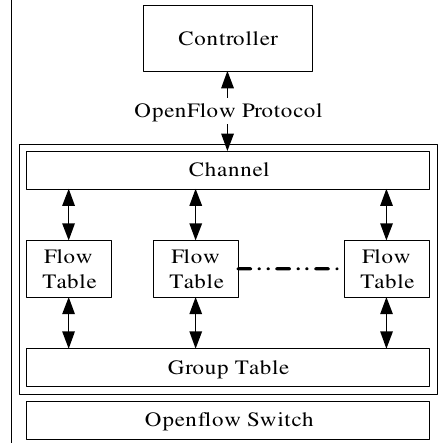
Figure 2. Overview of OpenFlow Design